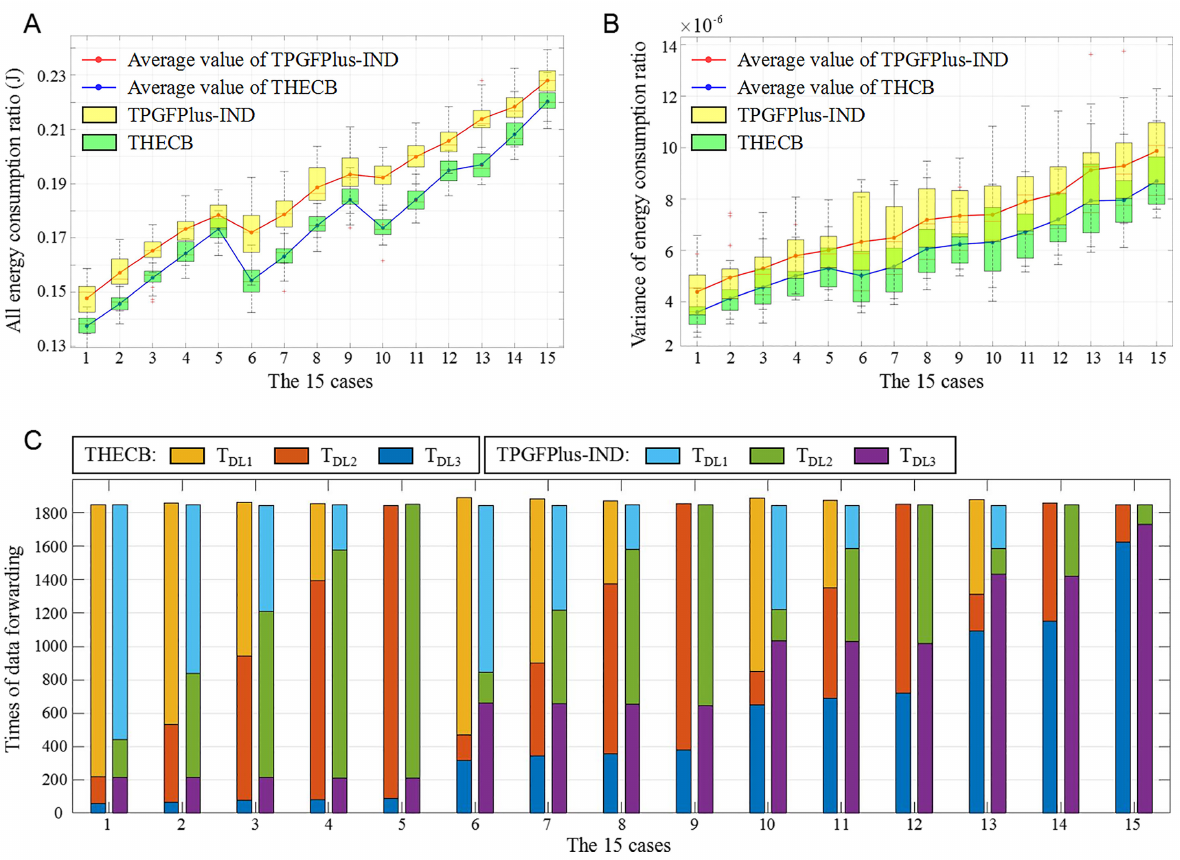
Figure 15. The performance of these algorithms with a varied proportion of different discharges levels. ( A ) Total energy consumption ratio. ( B ) Variance of energy consumption ratio. ( C ) The times of participating in data